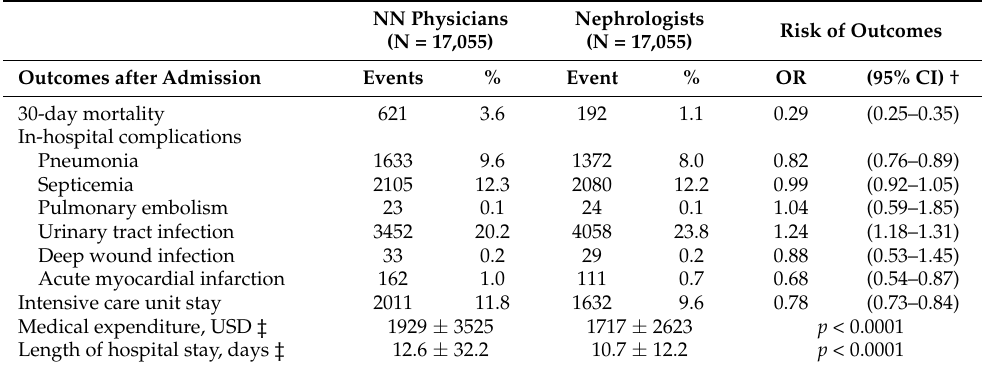
Table 2. The comparison of outcomes after admissions due to kidney diseases in patients received care by nephrologists and non-nephrologist physicians.